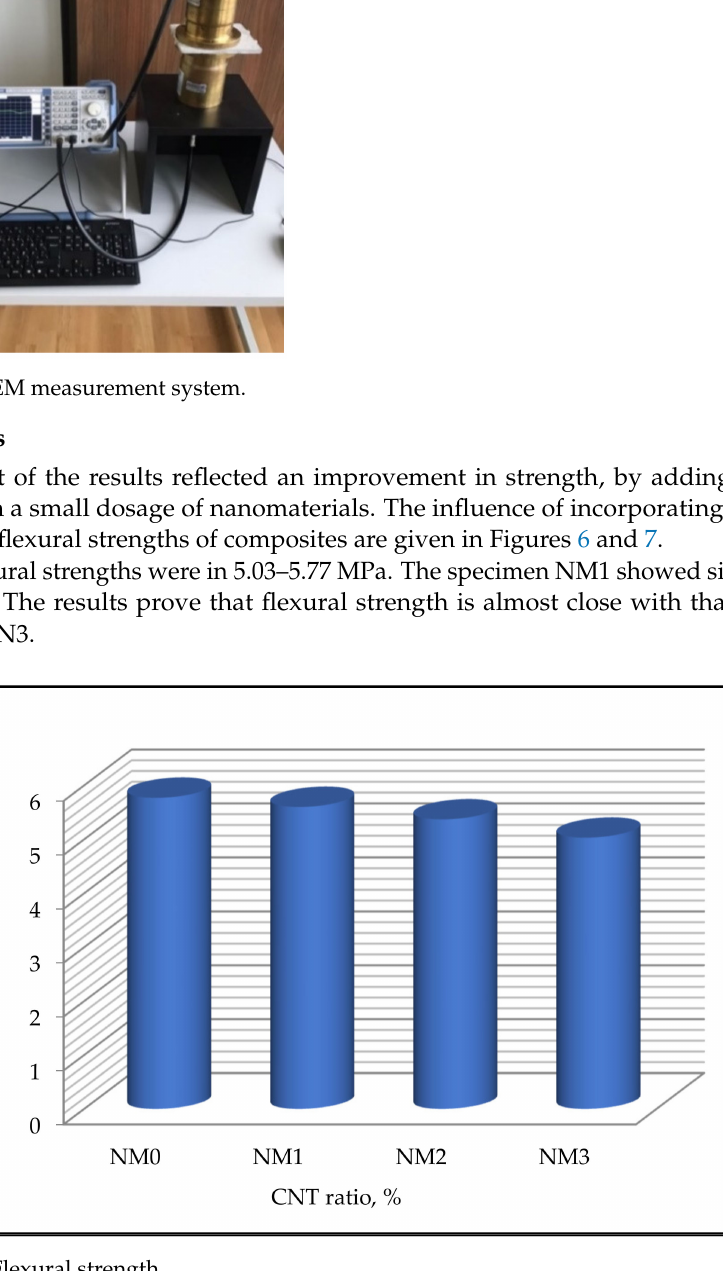
Figure 6. Flexural